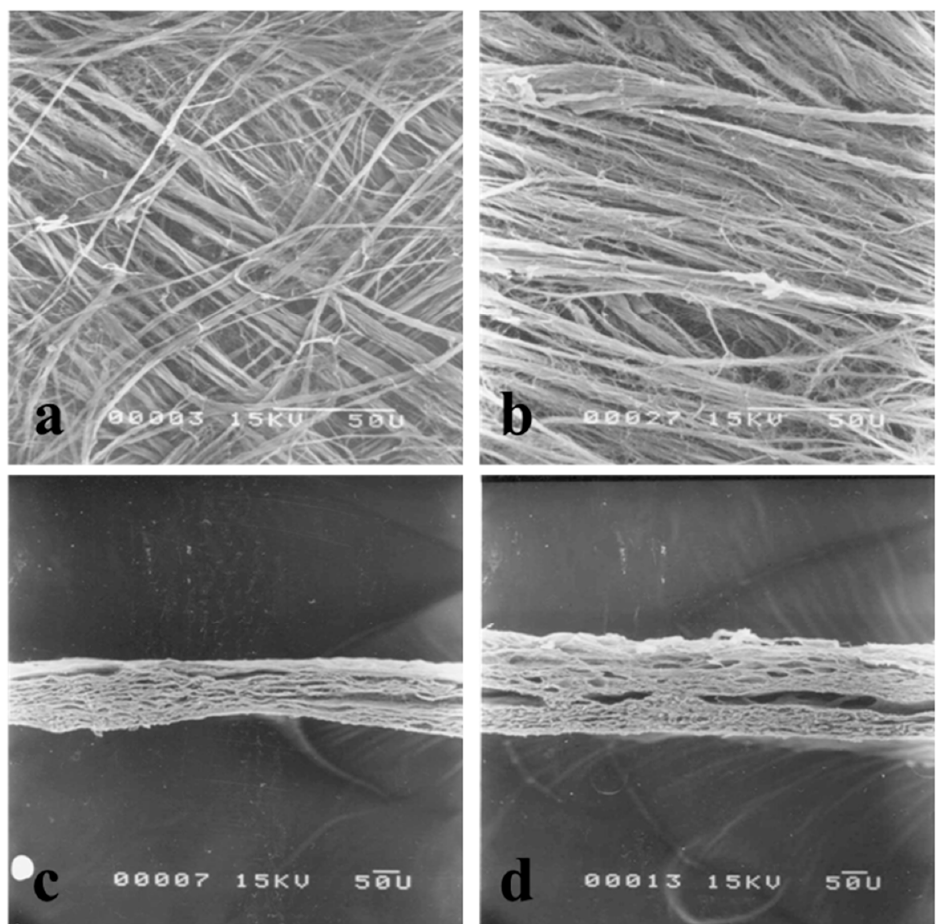
Figure 4. Comparison of collagen fibrous structures of lamb and sheep casings observed using a scanning electron microscope (scale bar, 50 µ m). The size and arrangement of collagen fibers on the external surface of lamb and sheep casings are shown in ( a , b ), respectively. The thickness of lamb and sheep casings is shown in ( c , d ),